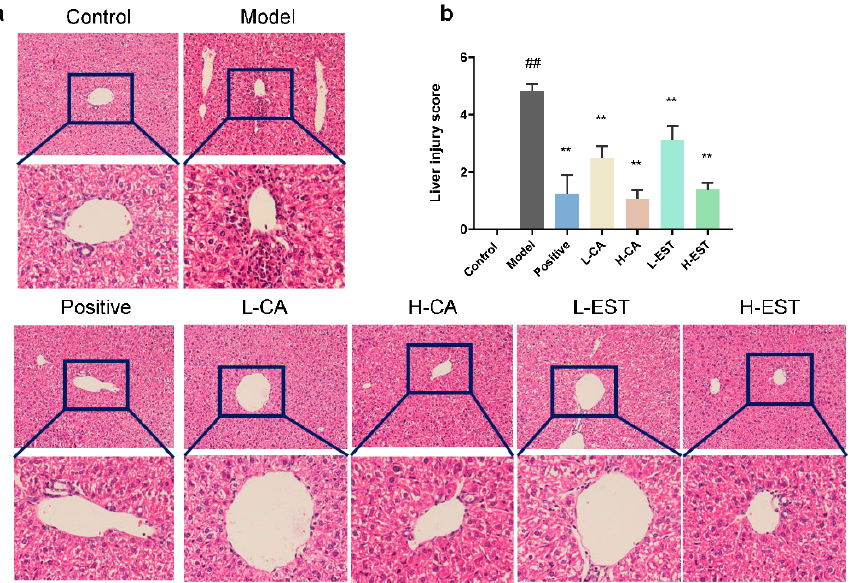
Figure 2. ( a ) Histopathological liver tissue (100×), ( b ) the liver injury score of mice in different groups. Data are expressed as mean ± SD of at least three independent experiments ( n ≥ 5). ## p < 0.01 compared with the control group, and ** p < 0.01 compared with the model group.